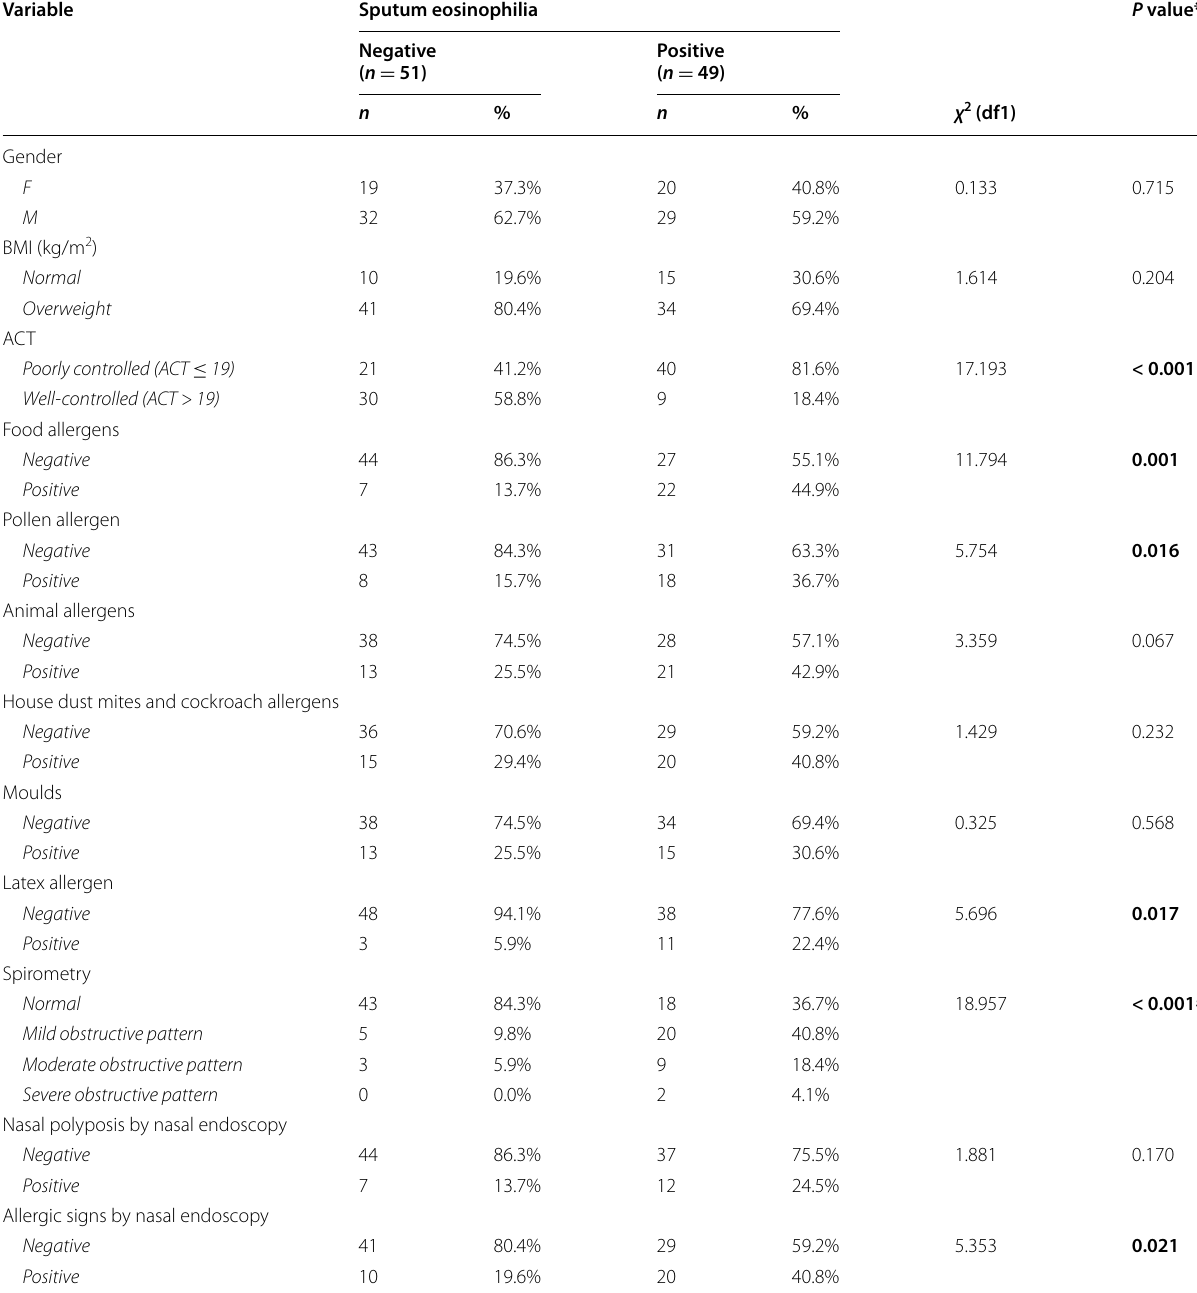
Table 2 Comparison of patients with or without sputum eosinophilia: categorical